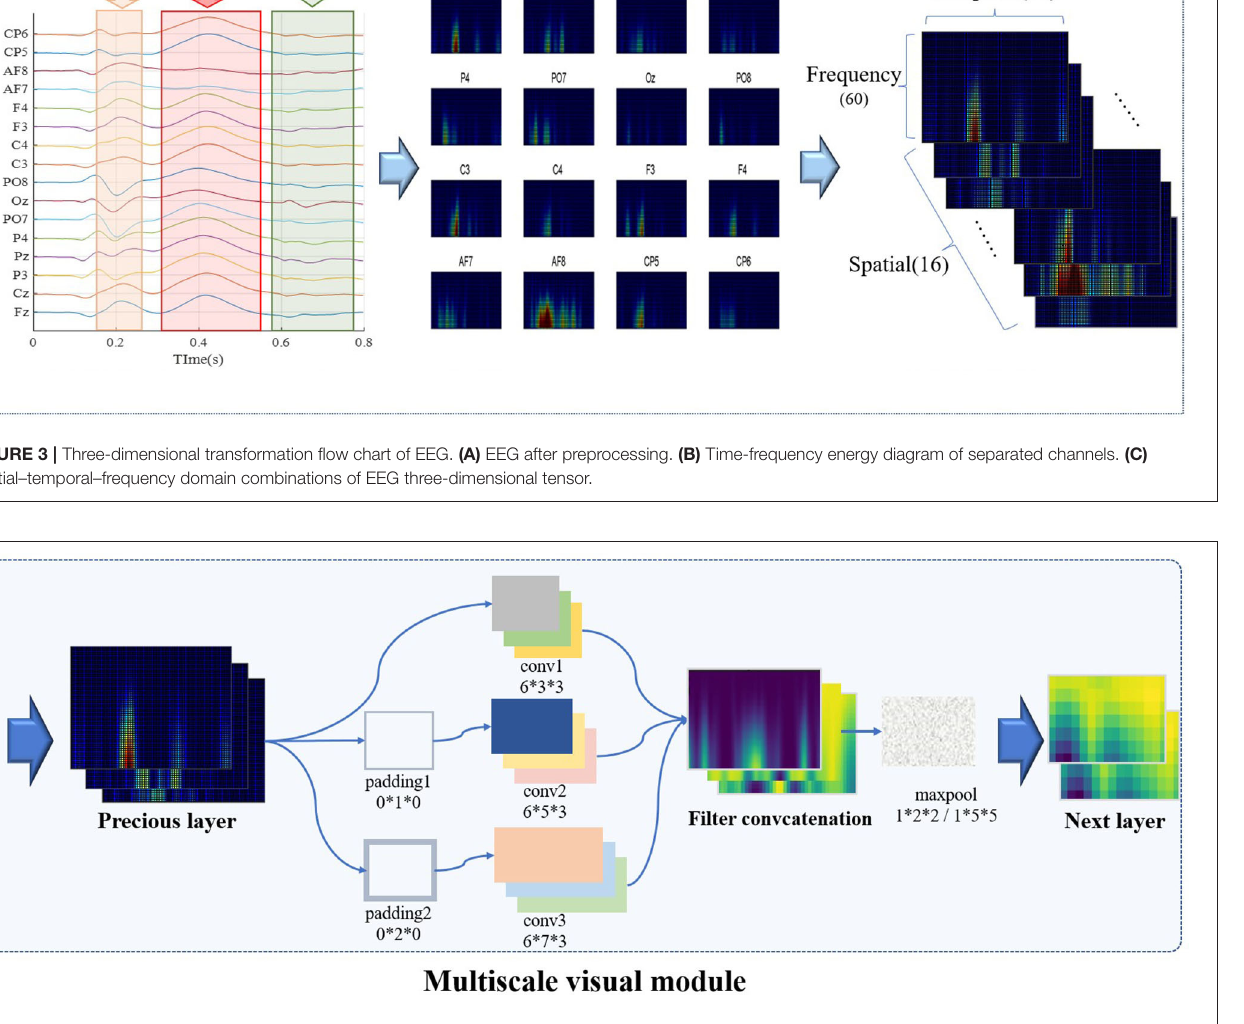
FIGURE 4 | The architecture of multi-scale vision convolution